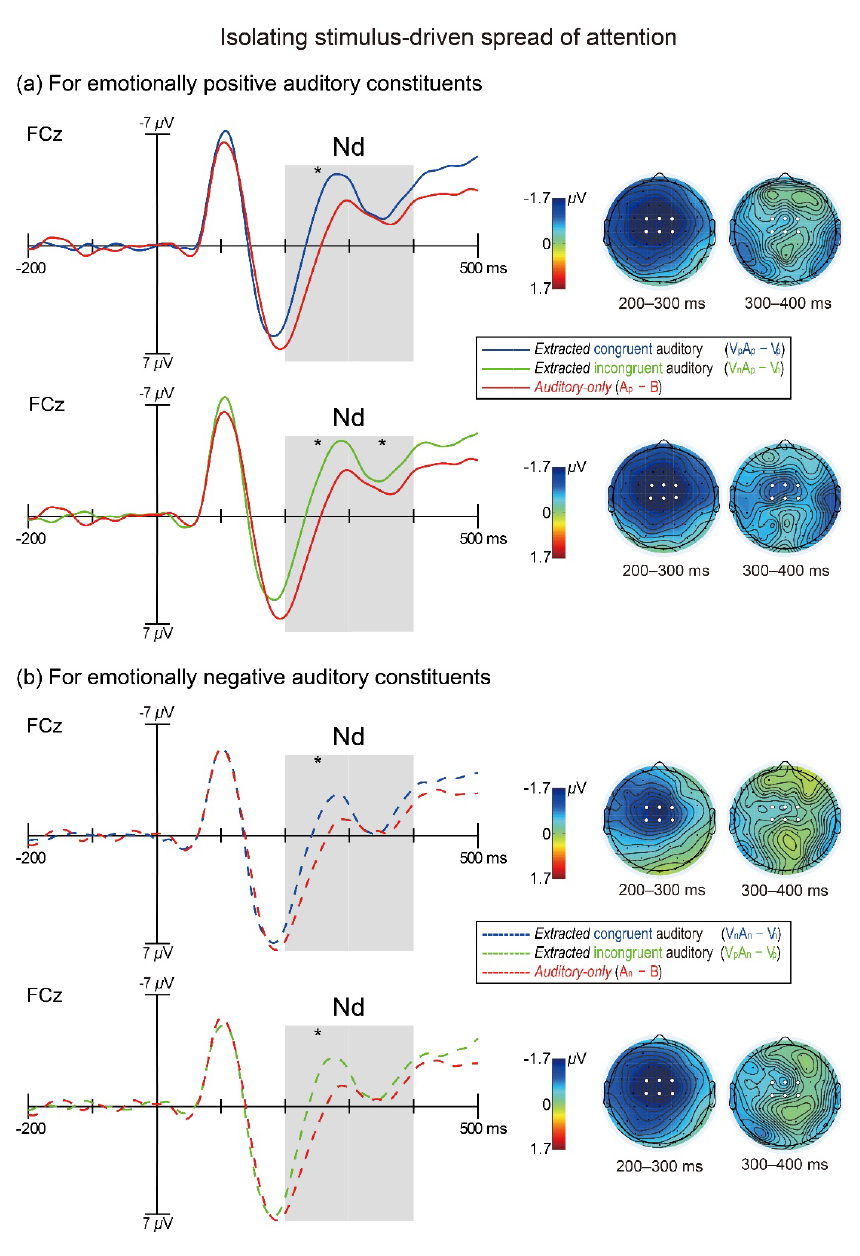
Figure 2. The extracted auditory ERP waveforms to emotionally congruent (blue traces) and incon- gruent (green traces) nontarget audiovisual stimuli and ERP waveforms evoked by auditory-only nontarget stimuli (red traces), plotted separately for ( a ) emotionally positive auditory constituents (solid traces) and ( b ) emotionally negative auditory constituents (dashed traces). These ERP wave- forms are from the fronto-central electrode FCz and the shaded areas on waveforms depict the two-time windows (200–300 ms and 300–400 ms) within which the Nd component was measured. Scalp topographies are shown for the extracted-auditory minus auditory-only mean difference am- plitudes during each Nd interval. The white dots on topographies depict the fronto-central ROI (FC1, FCz, FC2, C1, Cz, C2) over which the Nd component was measured. The stimulus-driven Nd component, indexed by significantly greater negative amplitude in the extracted auditory than auditory-only waveform, was prominent for all audiovisual emotional combinations within the time window of 200–300 ms. In contrast, only the incongruent audiovisual pairs with emotionally positive auditory and negative visual constituents (V n A p ) produced a sustained Nd within the time window of 300–400 ms. *: p < 0.05 for the extracted-auditory vs. auditory-only